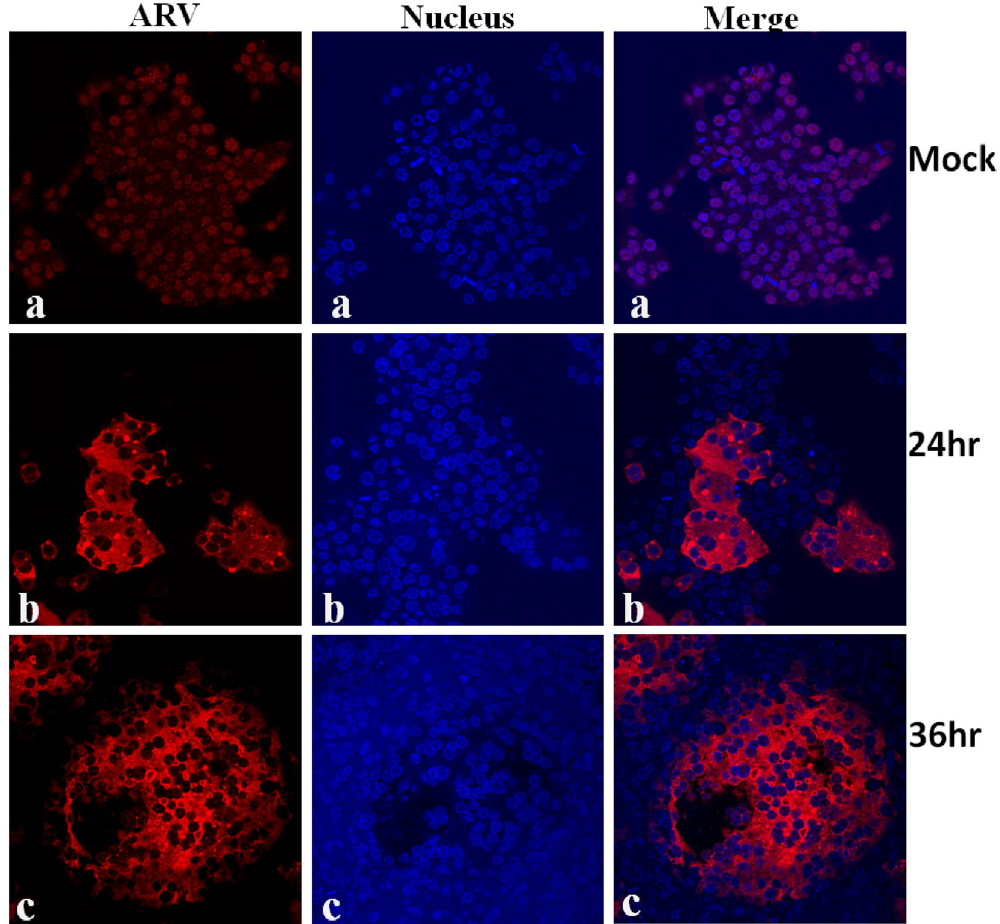
Figure 3. Indirect immunostaining of mock or virus infected cells using anti ARV primary antibody and AlexaFlour 647 conjugated secondary antibody. (Panel a) mock infected LMH cells. (Panels b and c) 24 hr and 36 hr post infection of LMH cells with virus isolate, respectively. DAPI was used as a nuclear counter